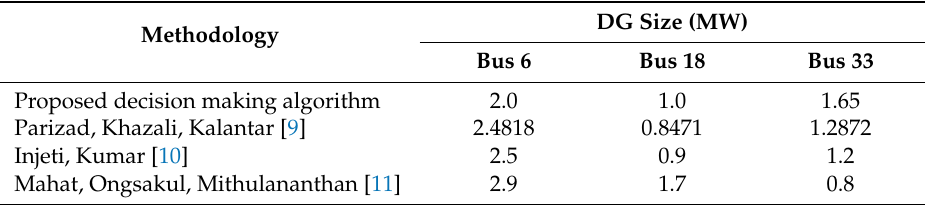
Table 4. Comparison of proposed method’s results with other methodologies.